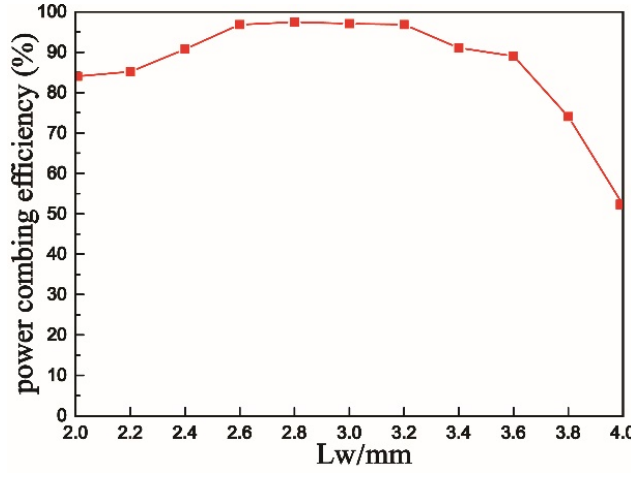
Figure 7. Power-combining efficiency under different coupling slot width w L .